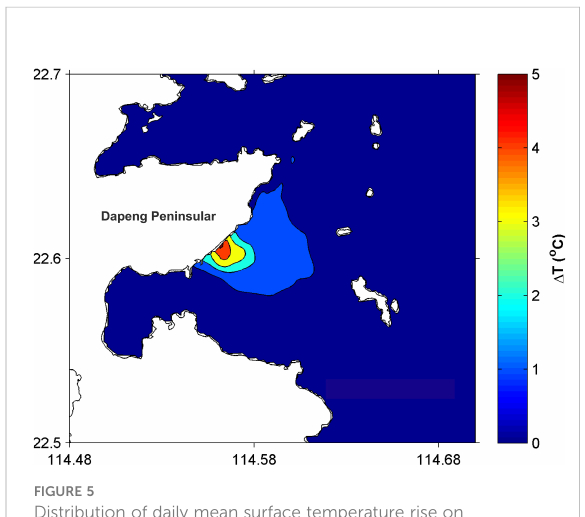
FIGURE 5 Distribution of daily mean surface temperature rise on September 21, 2008 calculated by the model of Daya